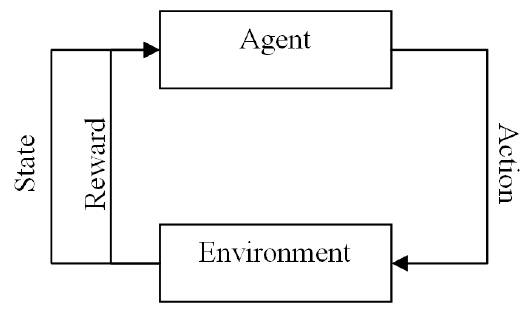
Figure 1. The schematic view of reinforcement learning.